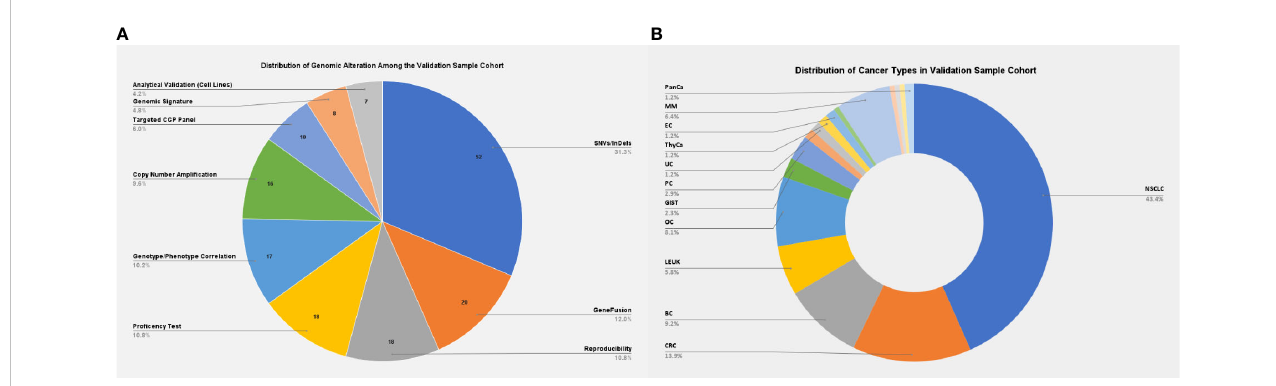
FIGURE 2 (A) Distribution of genomic alterations among the validation sample cohort. (B) Distribution of cancer types among the validation sample cohort. NSCLC, non-small cell lung carcinoma; CRC, colorectal cancer; BC, breast cancer; LEUK, leukemia; OC, ovarian cancer; GIST, gastrointestinal stromal tumors; PC, prostatic cancer; EC, endometrial cancer; MM, multiple myeloma; PanCa, pancreatic